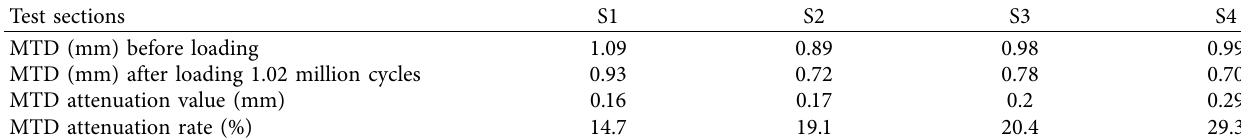
Table 7: MTD and loading cycles.